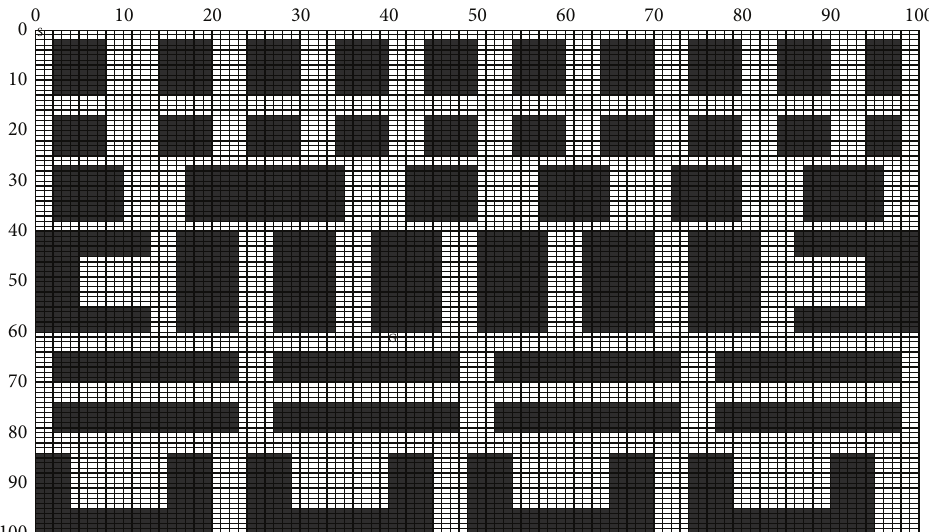
Figure 17: The working environment map III.